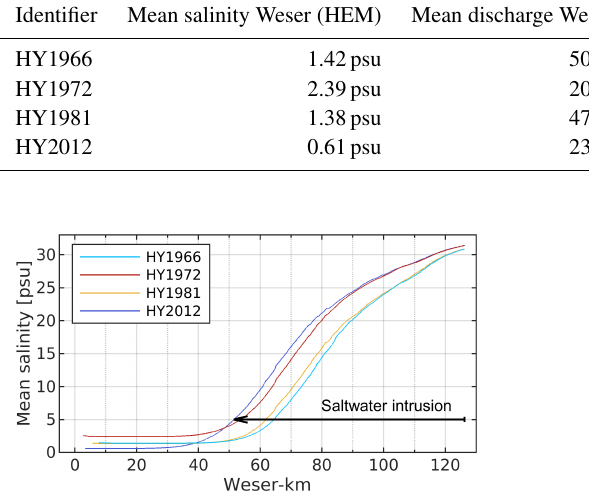
Figure 5. Annual mean, vertically averaged salinity along the navi- gation channel of the Weser estuary (see Fig. 1) in hindcast models of 1966, 1972, 1981, and